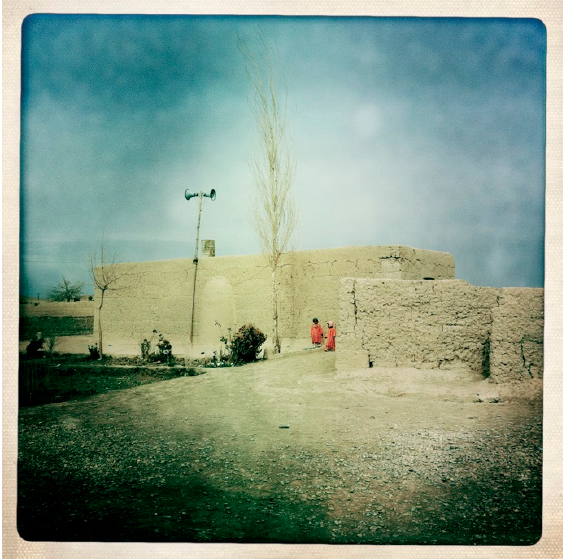
Figure 6. The Mosque. Source: created by Rita Leistner (used with photographer’s permission).